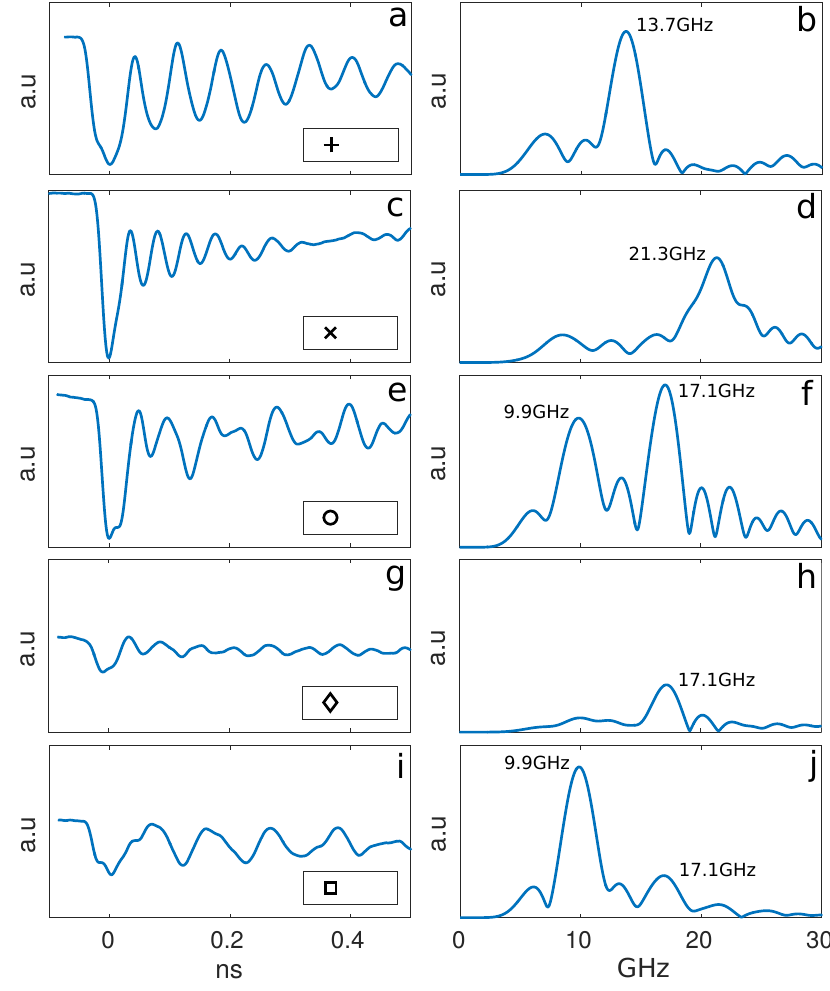
Figure 5. Experimental traces and their frequency spectrums, showing the main breathing mode frequencies. ( a , b ) example traces for the particle in Figure 4f; ( c , d ) example traces of the top particle for Figure 4h; ( e – j ) example traces for the middle particle in three different locations for Figure